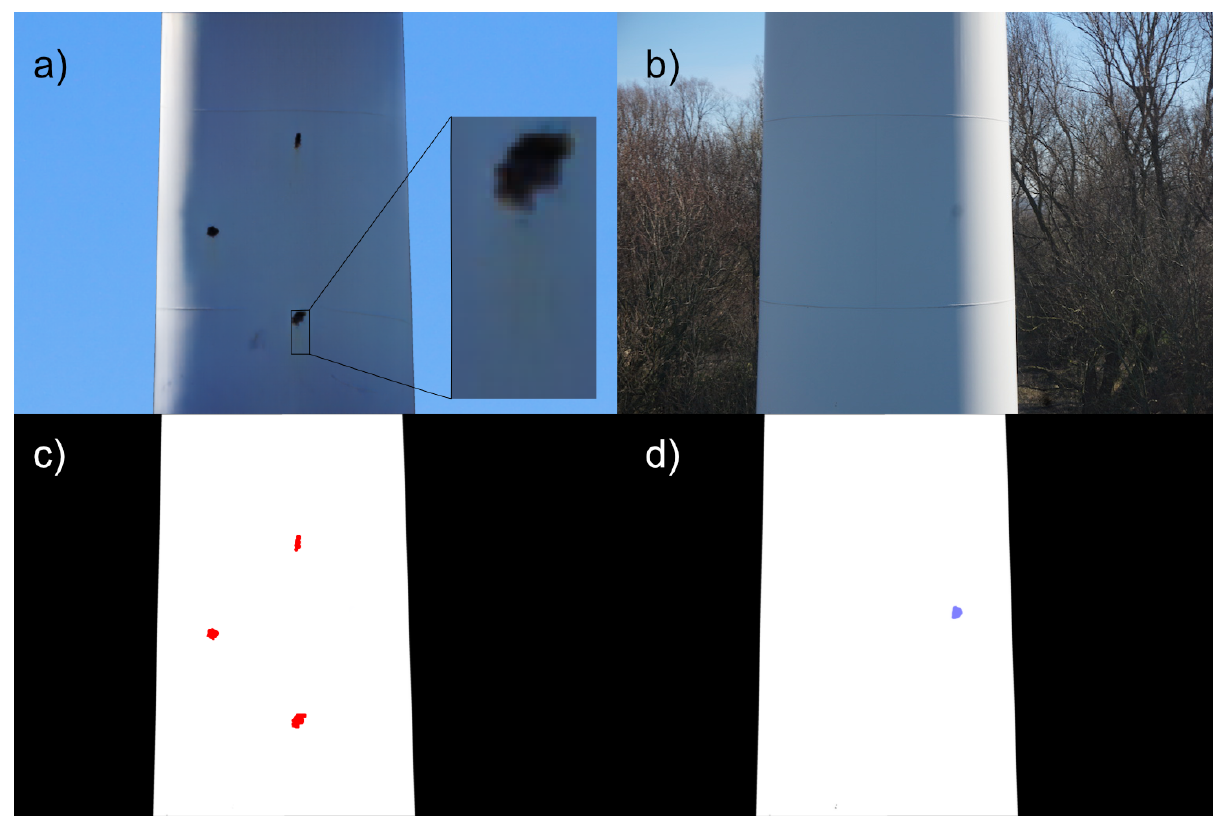
Figure 2. Synthetic image generation from segmentation masks. a) generated image, b) original image from test set, c) segmentation mask for image to be generated (see a), d) segmentation mask for original image (see b)